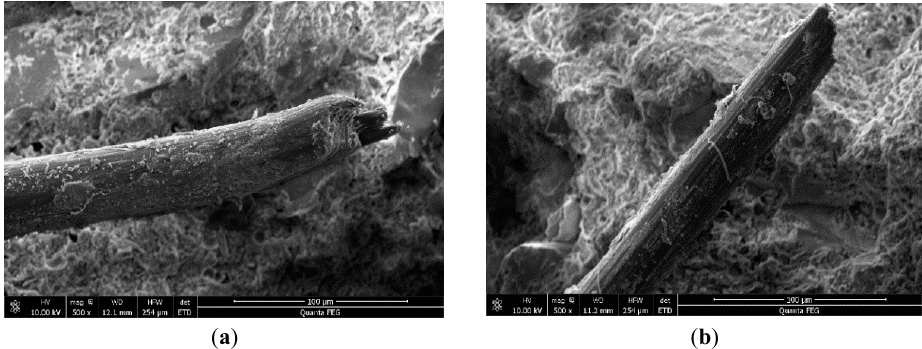
Figure 11. Microstructure of S4 and S2. ( a ) Untreated PVA fiber of S4; ( b ) Pretreated fiber of S2